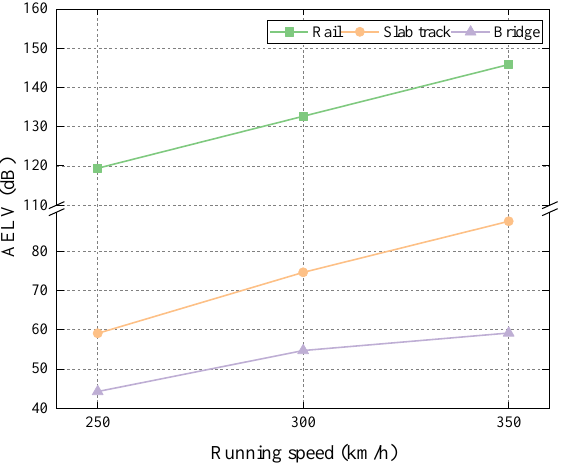
Figure 15. The AELVs of the track-bridge system. Figure 17. The AELVs of the track-bridge